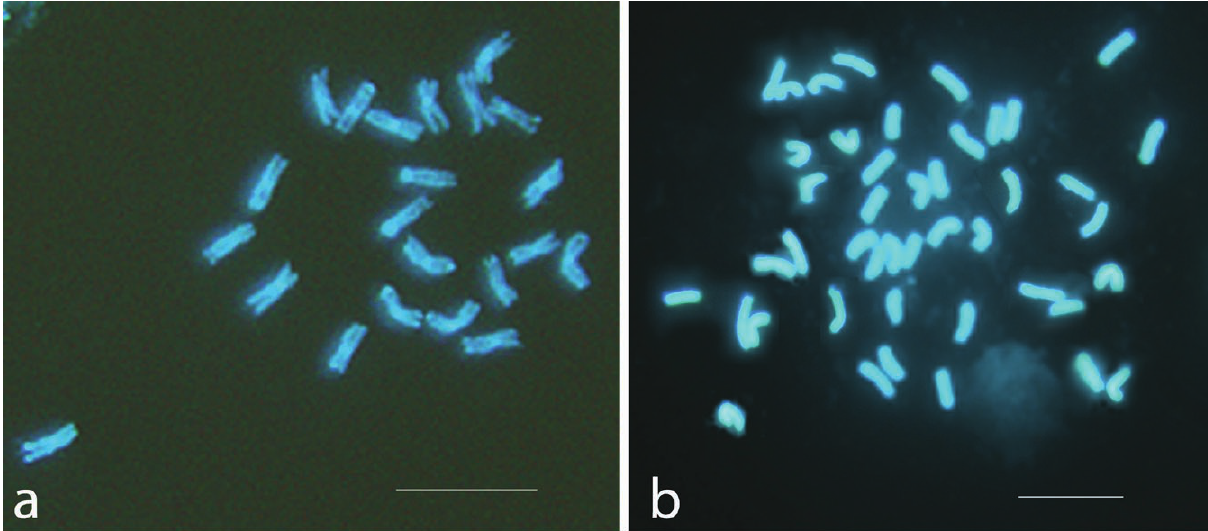
Figure 1. Mitotic metaphases of F. vulgare. Chromosome complements of diploid (a) and tetraploid (b) cytotypes. The bar represents 5μm.